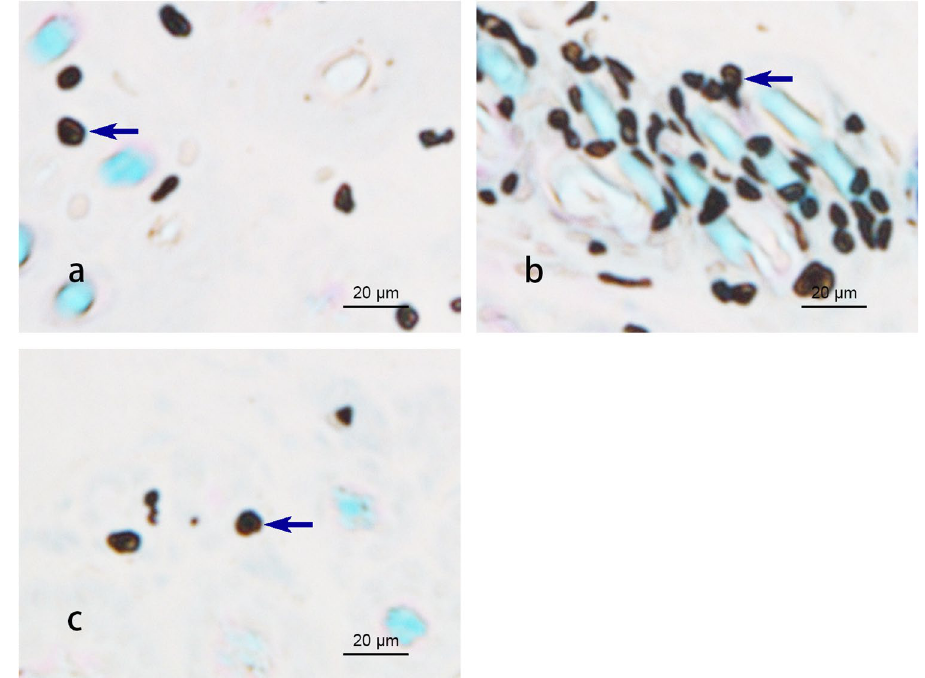
Figure 1. Densities of mast cells in the dermal tissue at PC 6, LU 7 and the non-acupoint ( × 400). Indicates mast